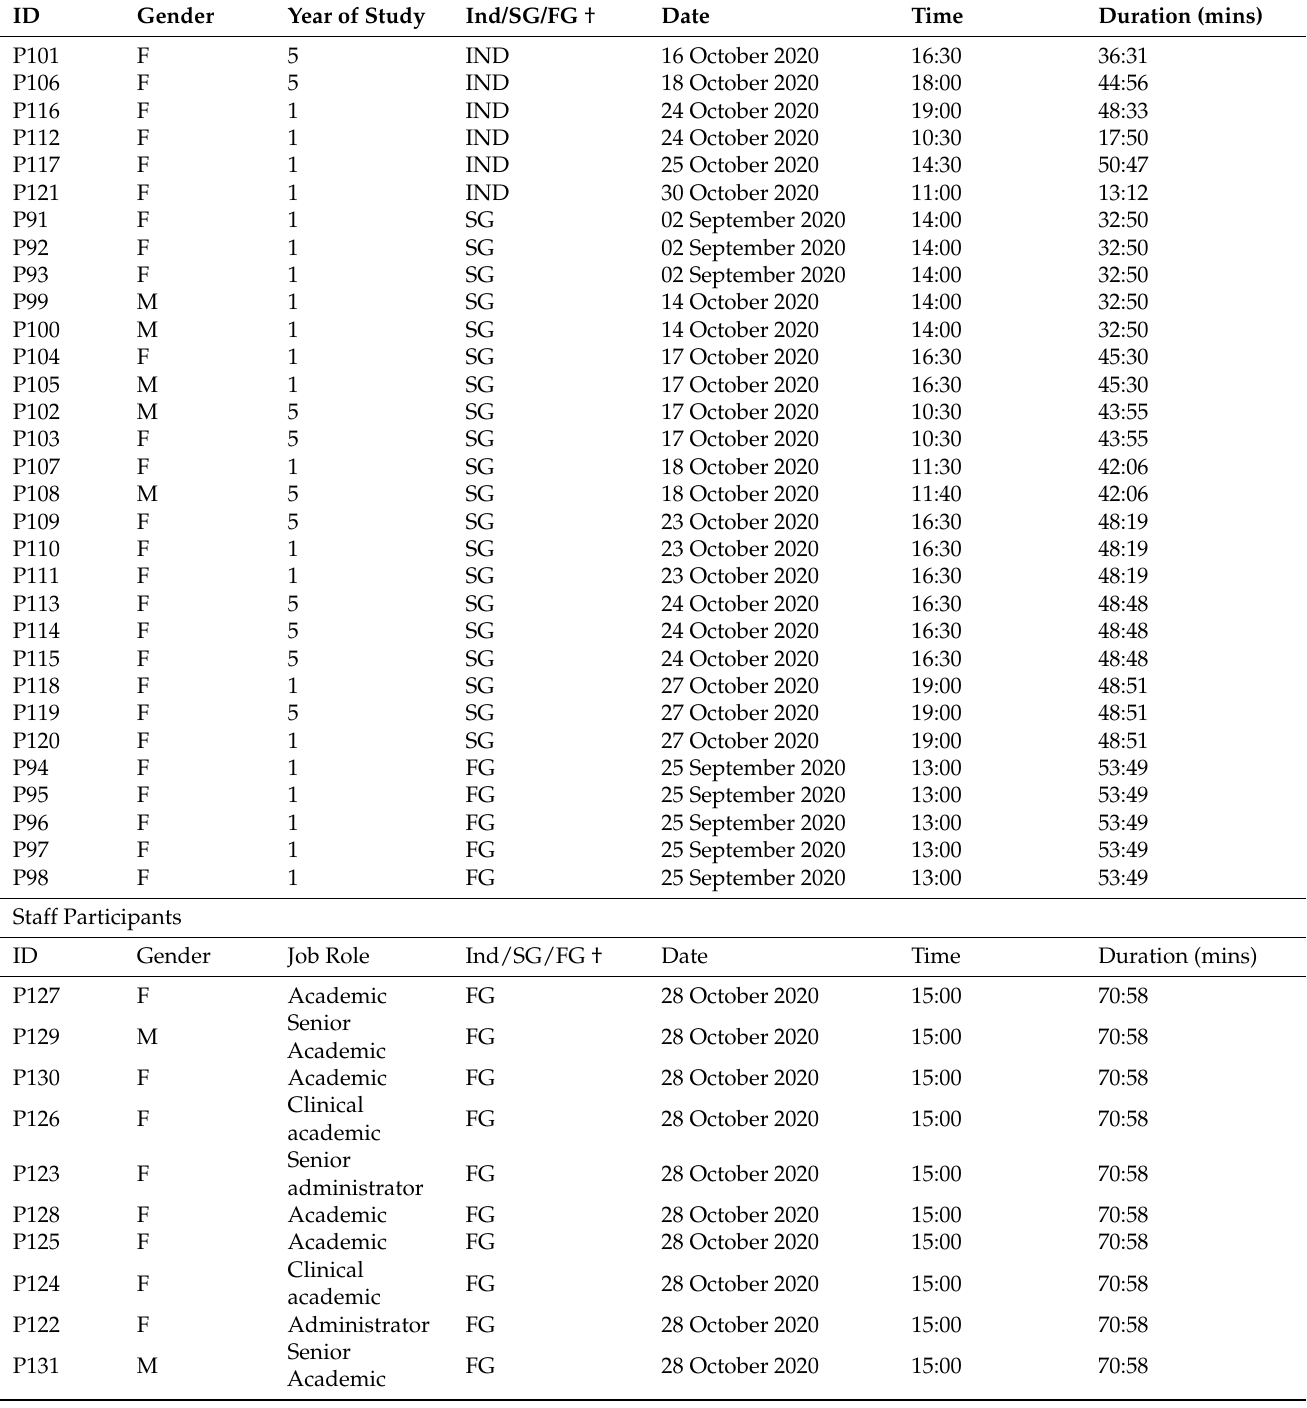
Table 1. Sample characteristics for interview and focus group